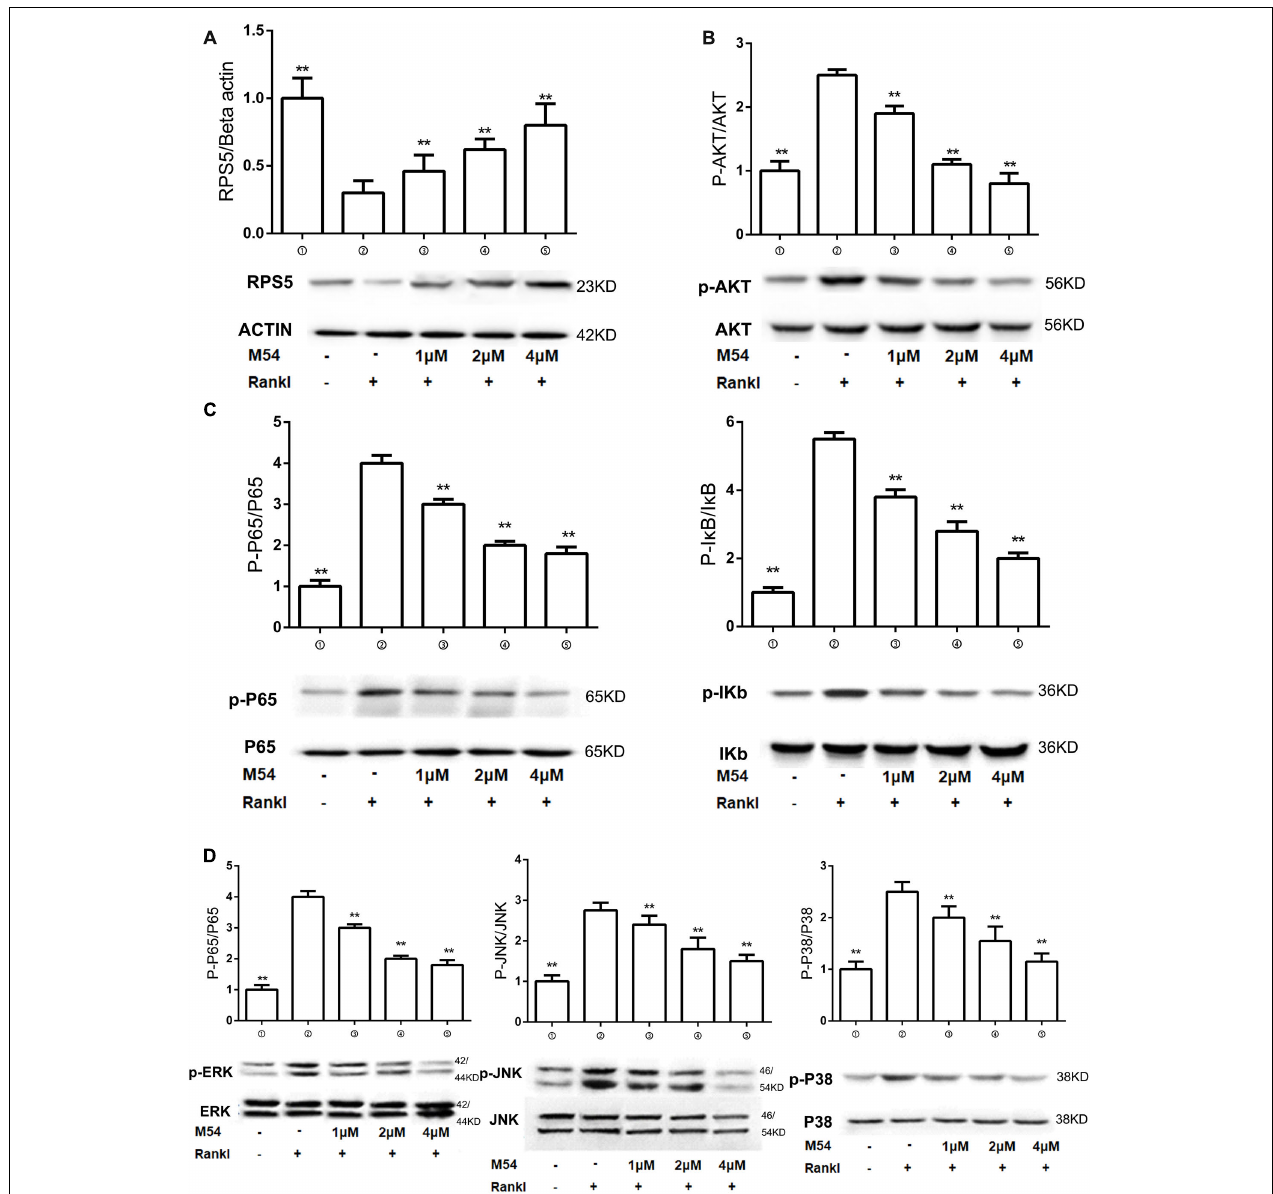
FIGURE 2 | M54 promotes RPS5 expression and suppresses PI3K/AKT, NF- κ B, and MAPK pathways activity pathways. (A) Western-blot results of RPS5 protein expression. (B) Phosphorylation of AKT protein, which was associated with PI3K/AKT pathway. (C) Phosphorylation of P65 protein, which was associated with NF- κ B pathway. (D) Phosphorylation of ERK, JNK, and P38 protein, which was associated with MAPK pathway. (cid:172) RAW264.7 cells; (cid:173) RAW264.7 cells induced with M-CSF, RANKL and PBS; (cid:174) RAW264.7 cells induced with M-CSF, RANKL and treated with 1 µ M M54; (cid:175) RAW264.7 cells induced with M-CSF, RANKL and treated with 2 µ M M54; (cid:176) RAW264.7 cells induced with M-CSF, RANKL and treated with 4 µ M M54 ( ∗ P < 0.05, ∗∗ P < 0.01 vs. (cid:173) ).